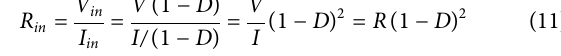
Frontiers in Energy Research |